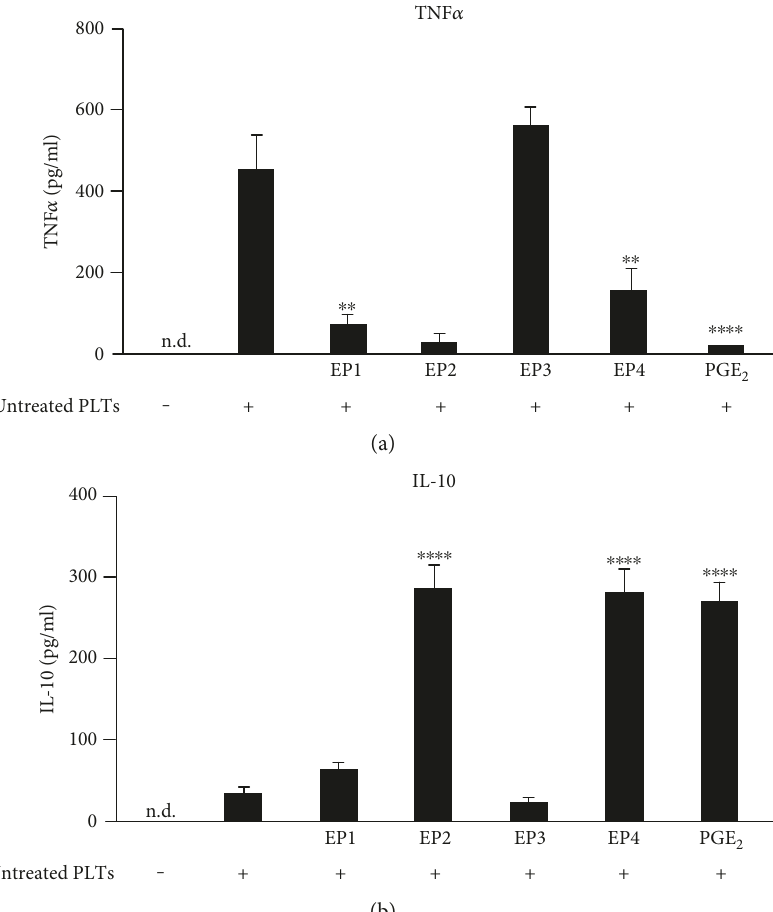
Figure 3: In fl uence of EP receptor agonists on the release of TNF α and IL-10 from platelet-stimulated murine macrophages. Murine BMDM were incubated alone or with untreated platelets and the respective EP agonist concentrations for 3 hours (400nM ONO-Di-004, 170 nM ). TNF α (a) or IL-10 (b) were determined by ELISA. Data are presented as butaprost, 10nM sulprostone, 5 nM L-902,688, 1 μ M PGE 2 mean ± SEM from 4 experiments. One-way ANOVA/Bonferroni ∗ P < 0 05 , ∗∗ P < 0 01 , ∗∗∗ P < 0 002 , ∗∗∗∗ P < 0 0004